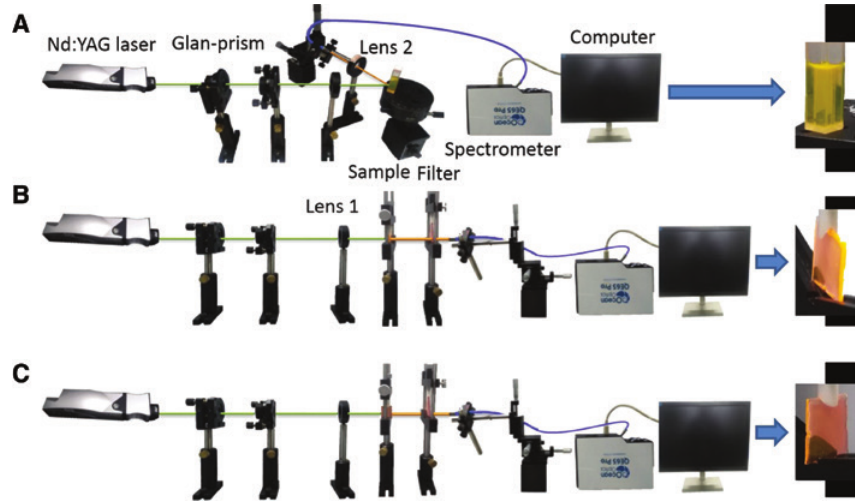
Figure 2: Measurement setup for different samples involved in the experiment. The measurement setup for the solution samples (A), the dip-coating polymer film (B), and the defect polymer waveguide film